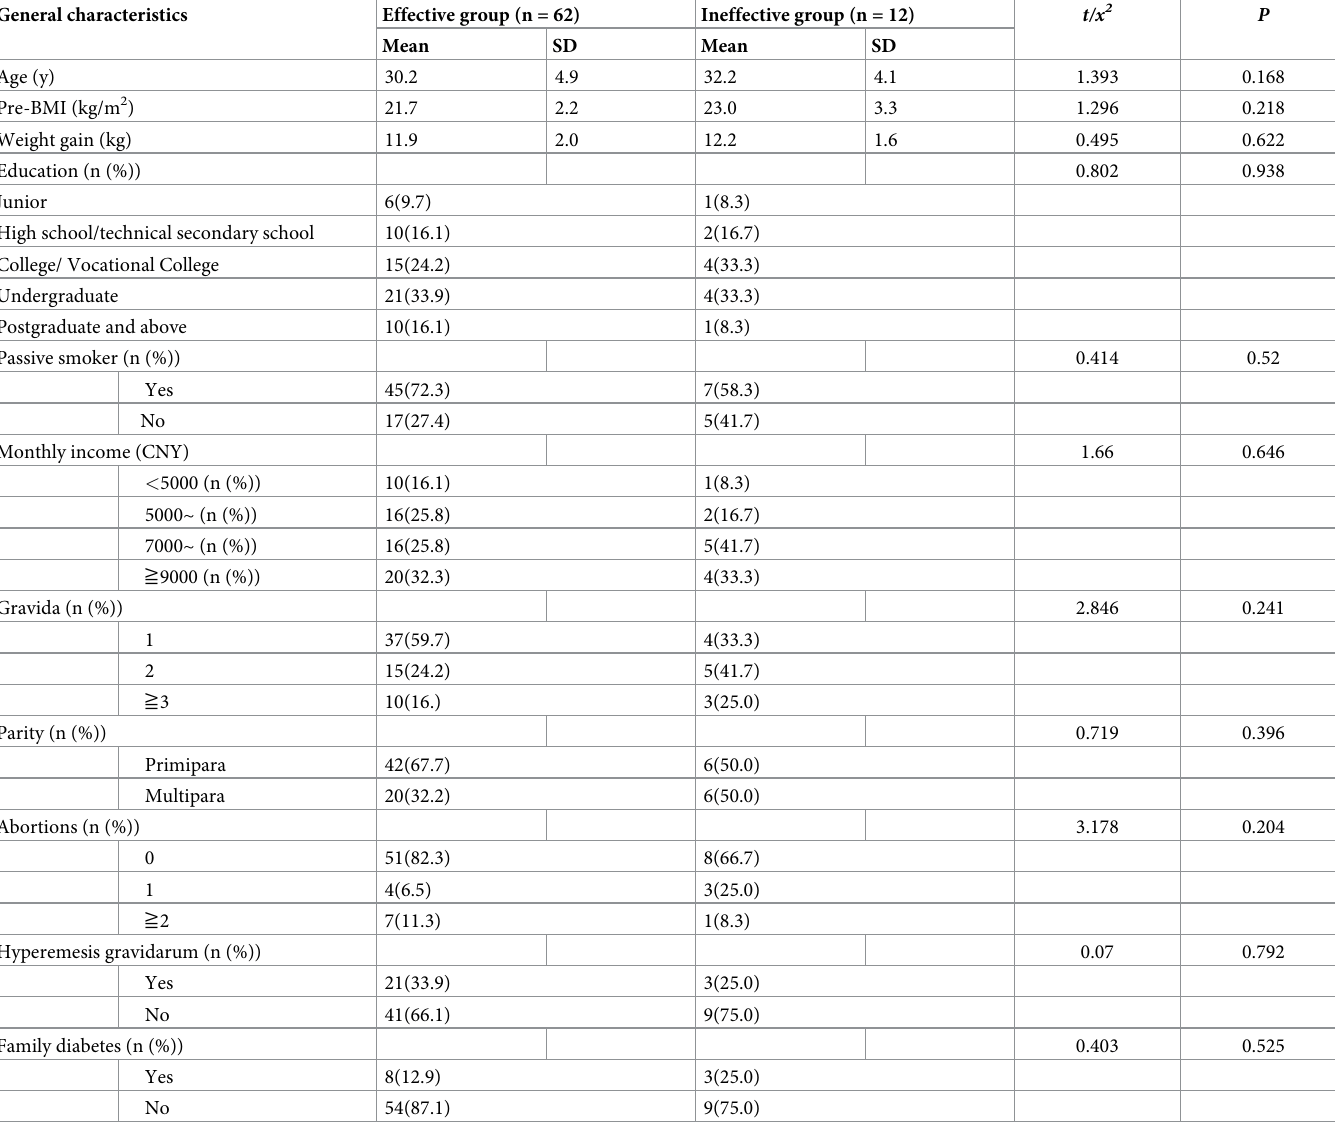
Table 1. Comparison of the basic demography, gestational history and pregnancy outcome of pregnant women in the blood glucose control effective group and ineffective group.